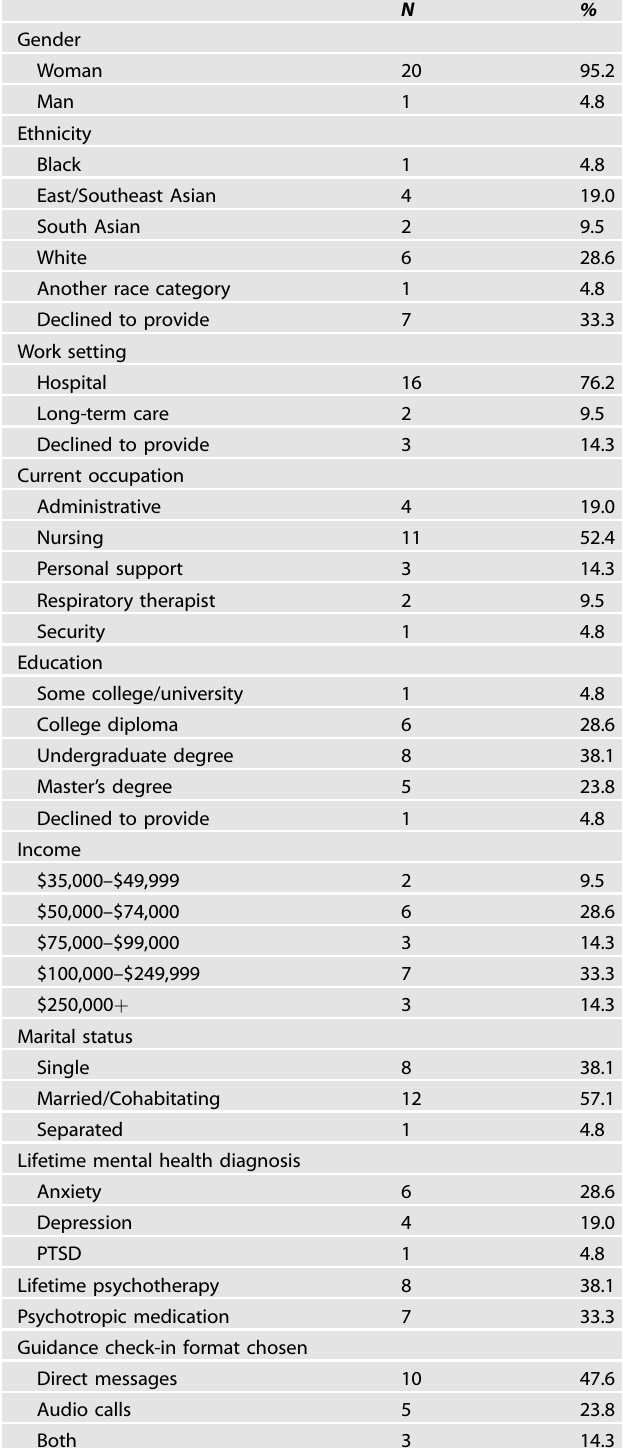
Table 1. Sample demographic and mental health